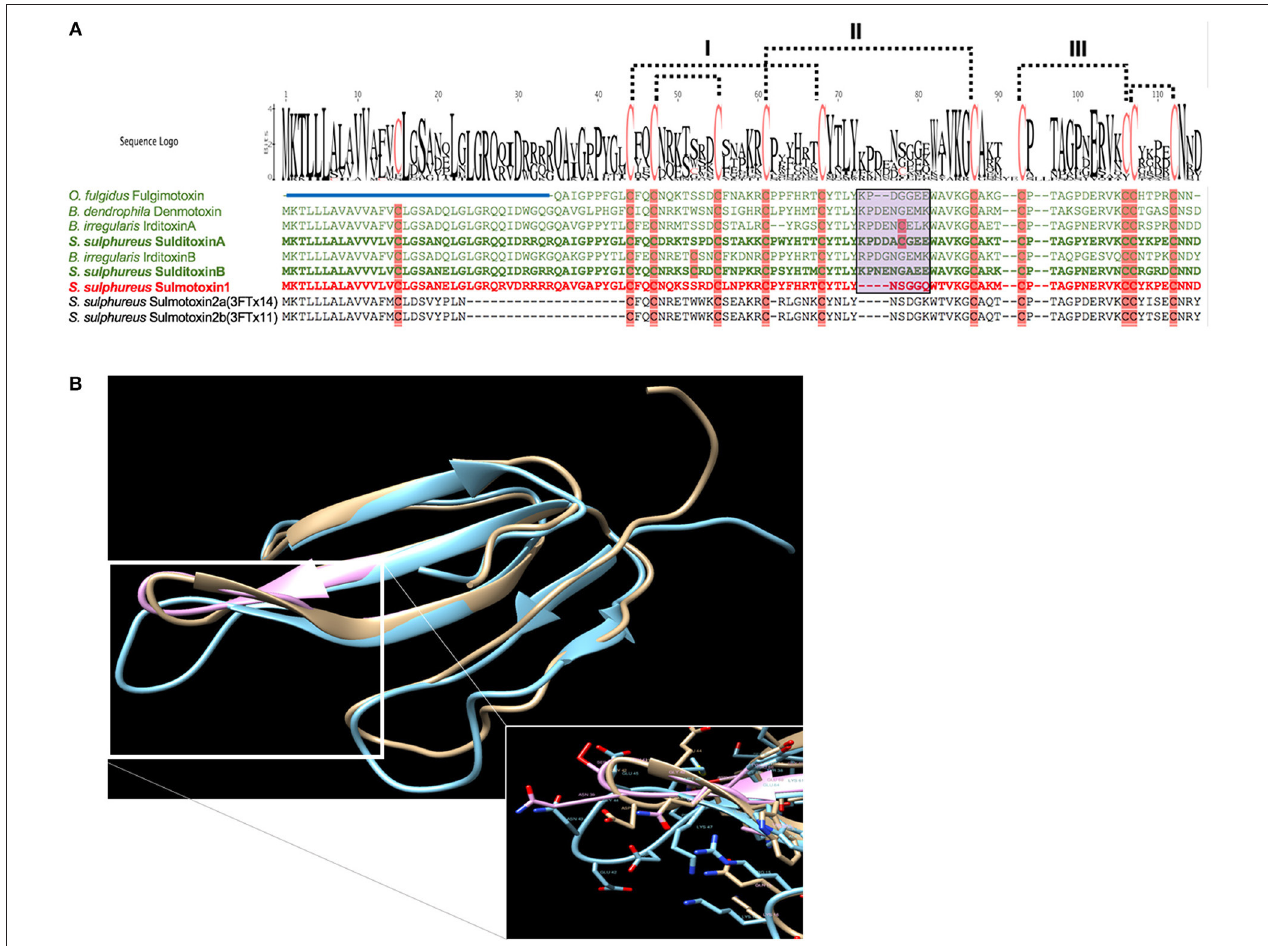
FIGURE 3 | Taxon-specific three-finger toxin (3FTx) sequences (A) and structures (B) . (A) Characterized lizard specific 3FTxs are shown in green, and sulmotoxin 1, a mammal-specific 3FTx, is in red. Sulmotoxin 2 is labeled twice because of the presence of two isoforms. Cysteines are highlighted in pink. The five disulfides characteristic of nonconventional 3FTxs are shown with dotted lines. The numbers above the alignments note the arrangement of the three 3FTx structural loops. Amino acid variation observed within the end of the central structural loop is highlighted in purple for characterized toxins. The signal peptides are indicated by the blue bar above all sequences except fulgimotoxin. (B) Structure of monomeric 3FTxs sulmotoxin 1 is displayed in pink, fulgimotoxin (C0HJD3.1) in orange, and denmotoxin (Q06ZW0.1) in blue. Differences in amino acids and the resulting structural alterations within the second/central 3FTx loop of lizard-specific monomeric 3FTxs are highlighted in insert. From Modahl et al.